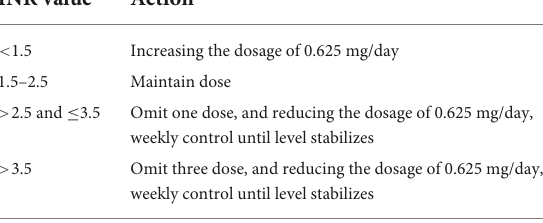
TABLE 1 Dose adjustment protocol according to international normalized ratio (INR) value in our anticoagulation